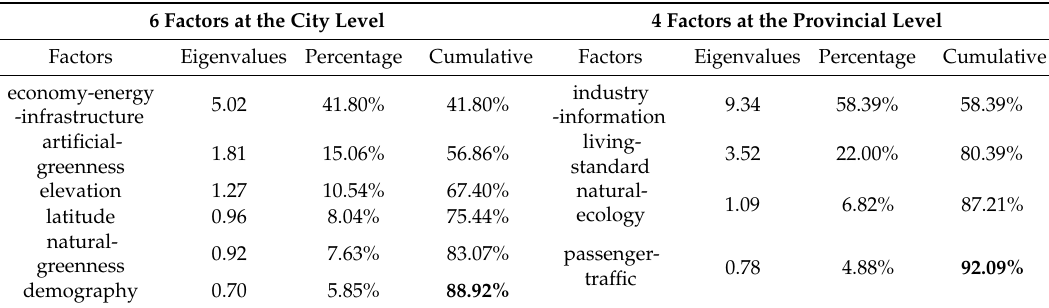
Table 2. Derivation of factors at the city level and provincial level using PCA analysis. Note: percentages in bold indicate the proportion of total variance that can be explained by the selected